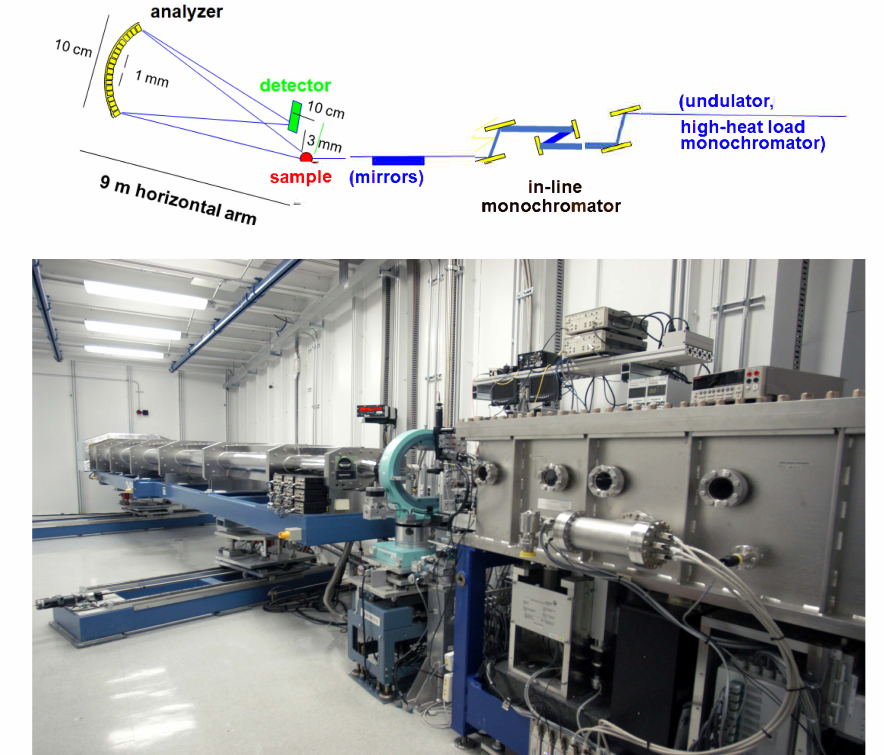
Figure 1. The upper panel represents a schematic diagram of the used instrument, while the lower one includes a picture of the sample spectrometer